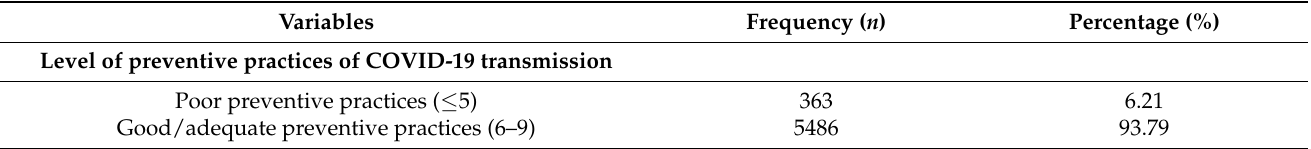
Table 4. Overall level of preventive practices of COVID-19 transmission ( n = 5849).